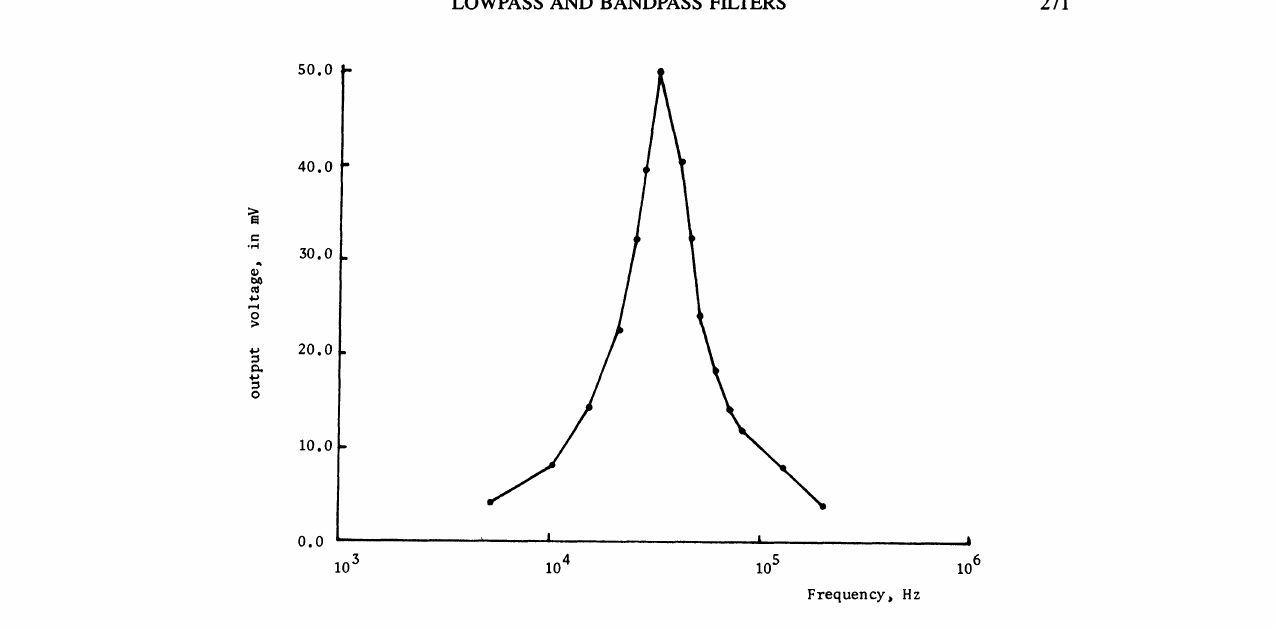
FIGURE 3 Simulated and calculated response of a BPF designed with: gm 3.9 mmho, R 998.3 ohm, C1= 10.414 nF, C2